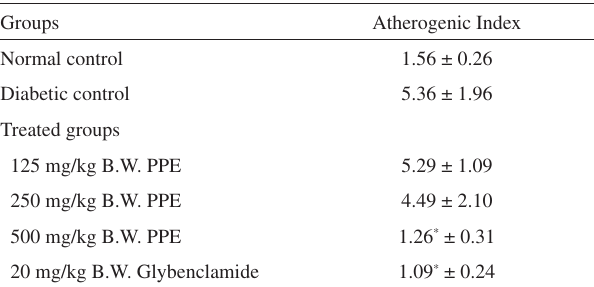
Table 4 - Effect of PPE on the atherogenic index of STZ- induced diabetic